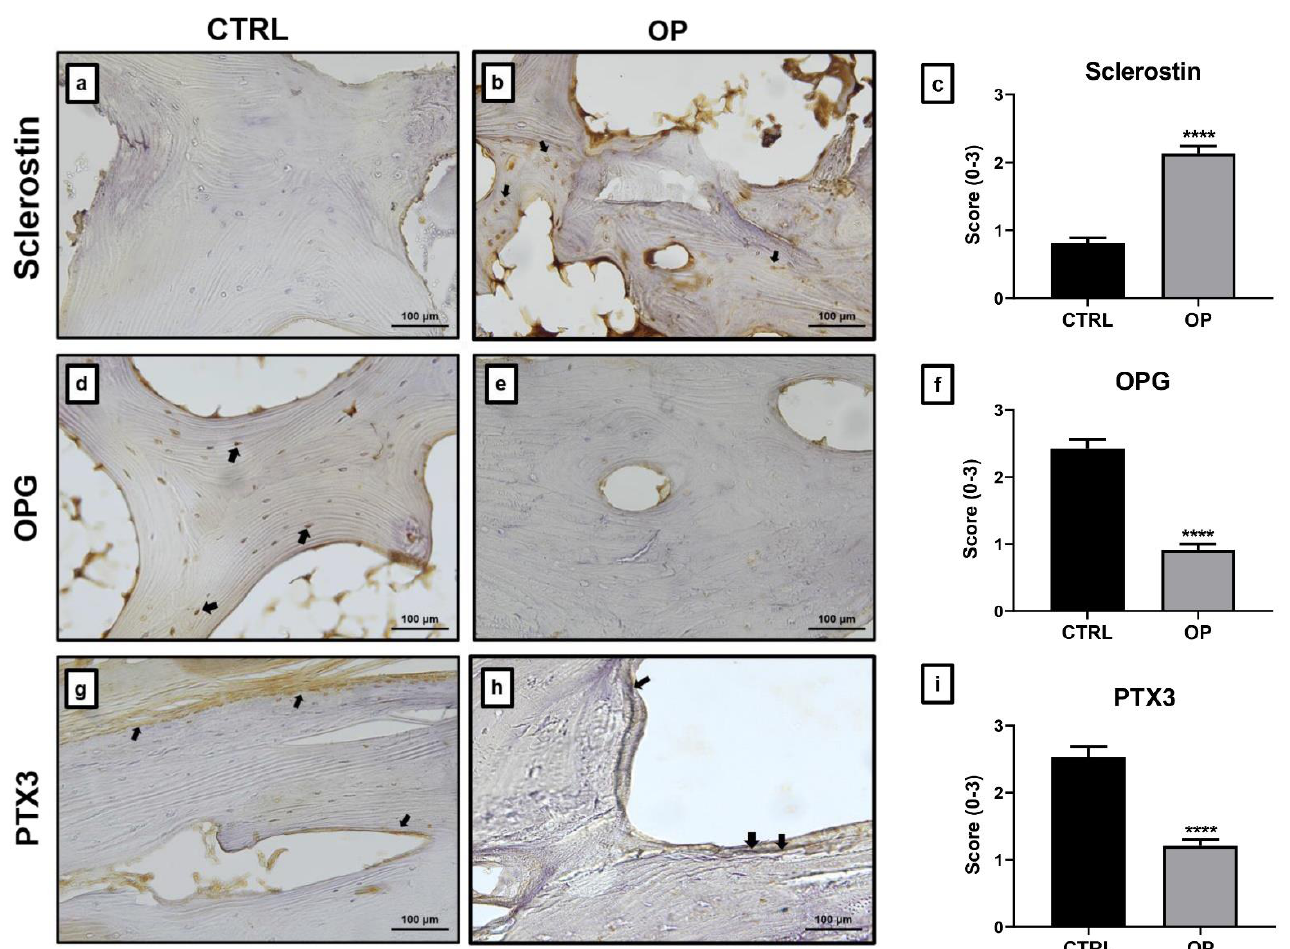
Figure 2. Sclerostin, osteoprotegerin (OPG) and pentraxin 3 (PTX3) expression. Immunohistochemical analysis of sclerostin, OPG and PTX3 expression in bone head biopsies. ( a ) Image displays few sclerostin-positive osteocyte cells in CTRL patients, ( b ) while OP patients showed numerous sclerostin-positive osteocytes (arrows). ( c ) Graph shows immunohistochemical results for sclerostin expression (CTRL vs. OP, **** p < 0.0001). ( d ) Numerous OPG positive osteoblast were present in the trabecular bone of CTRL patients (arrows), ( e ) while OP patients showed low OPG expression. ( f ) Graph shows immunohistochemical results for OPG expression (CTRL vs. OP, **** p < 0.0001). ( g ) CTRL patients showed PTX3 expression both in osteoblasts and bone marrow cells (arrows), ( h ) while OP bone tissue showed significantly lower PTX3-positive osteoblasts. ( i ) Graph displays immunohistochemical results for PTX3 expression (CTRL vs. OP, **** p < 0.0001). 20x images, scale bar represents 100 μm.